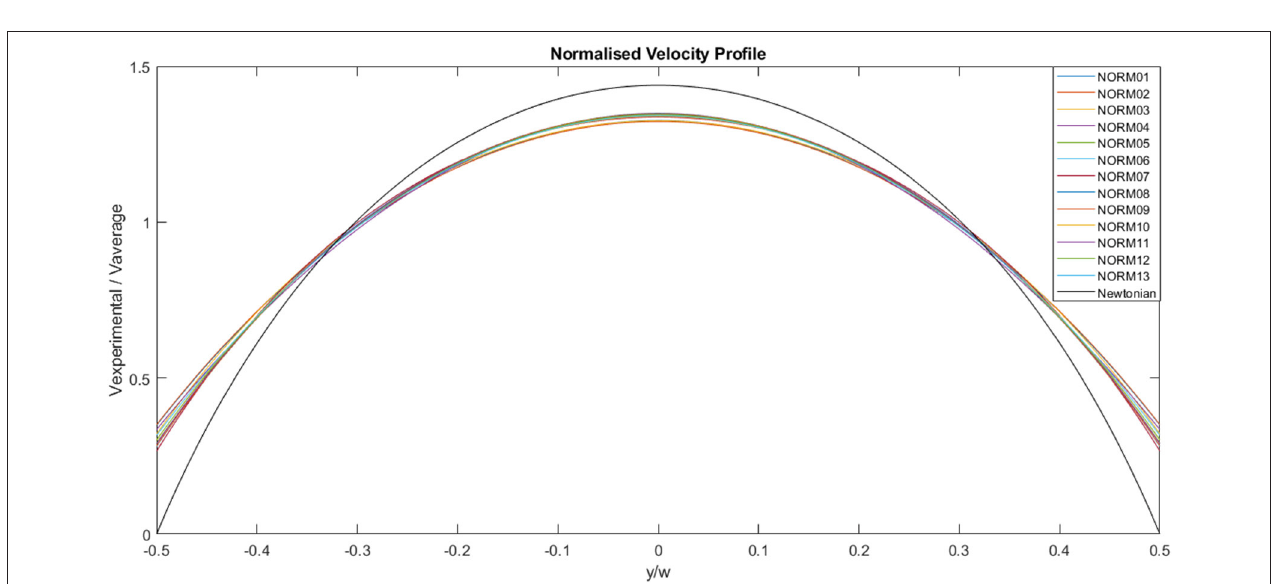
FIGURE 6 | Experimentally measured flow velocities across the channel width for a range of flow rates ( µ PIV study). EXP01 is the lowest flow rate and EXP13 the highest.